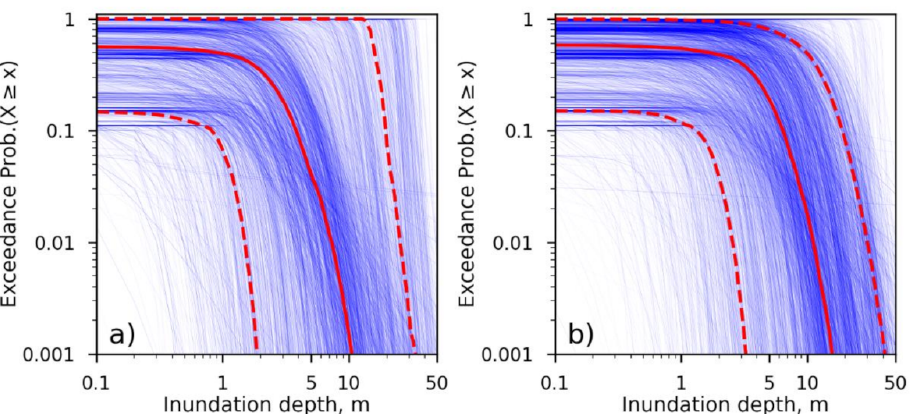
Figure 7. Individual tsunami hazard curves of the buildings at specific building points (light blue) including the mean and 10th–90th percentile confidence interval for an inundation depth of 0.1 m. ( a ) northern coastal area, and ( b ) southern coastal